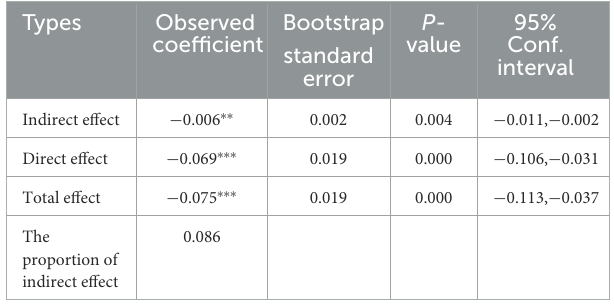
TABLE 4 Results of mediating